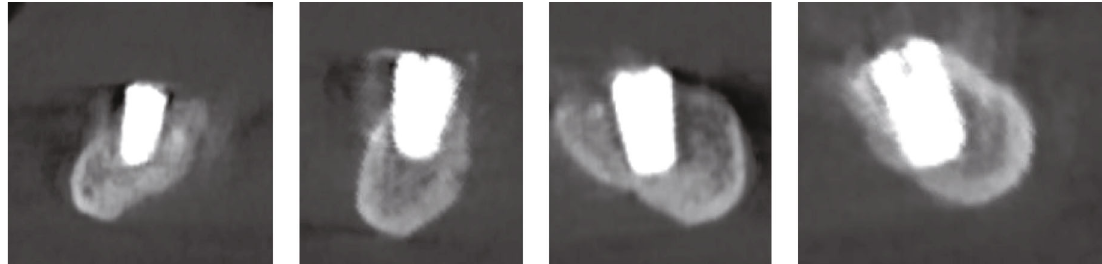
Figure 6: С BCT scan with implants in situ.